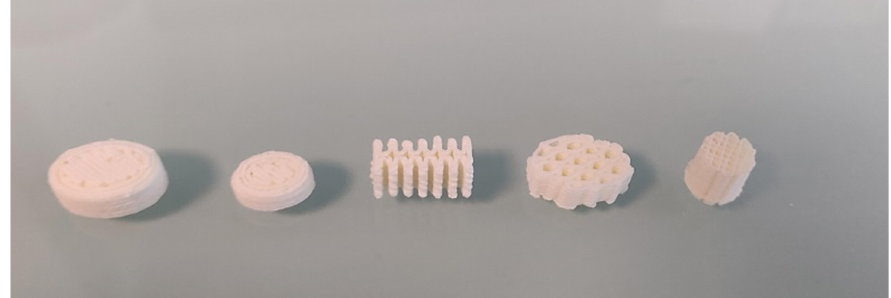
Figure 14. Photo of oral amiodarone forms showing different shapes and sizes.